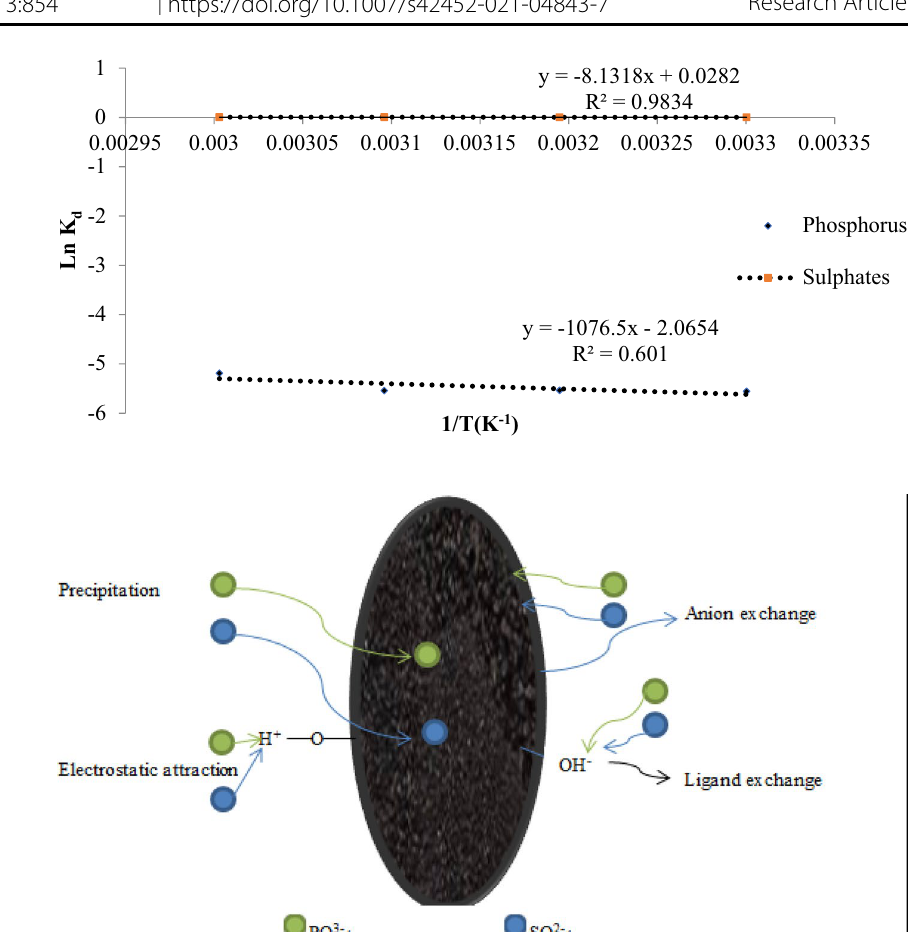
Fig. 10 Van’t Hoff’s plot for sorption of phosphorus and sulphate onto copper smelter slag at 303,313,323 and 333 K